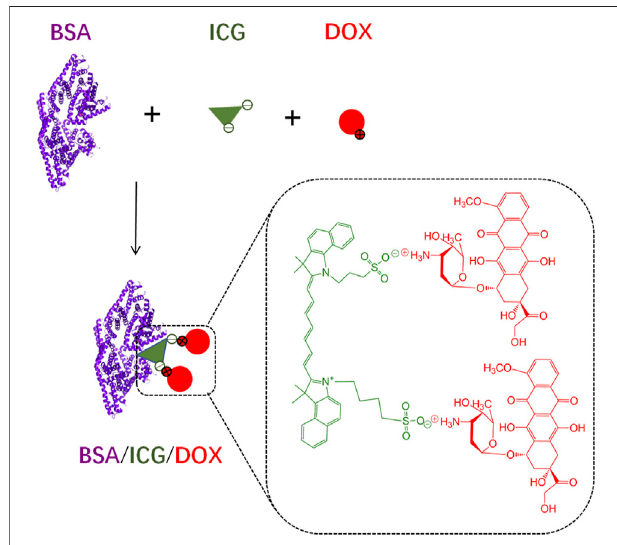
FIGURE 1 | The schematic diagram of BSA/ICG/DOX formation in deionized water. The ICG/DOX electrostatic interactions and strong binding capacity of ICG with BSA enable the aggregate formation of the above three substances. These aggregates are probably unstable in a complex environment.